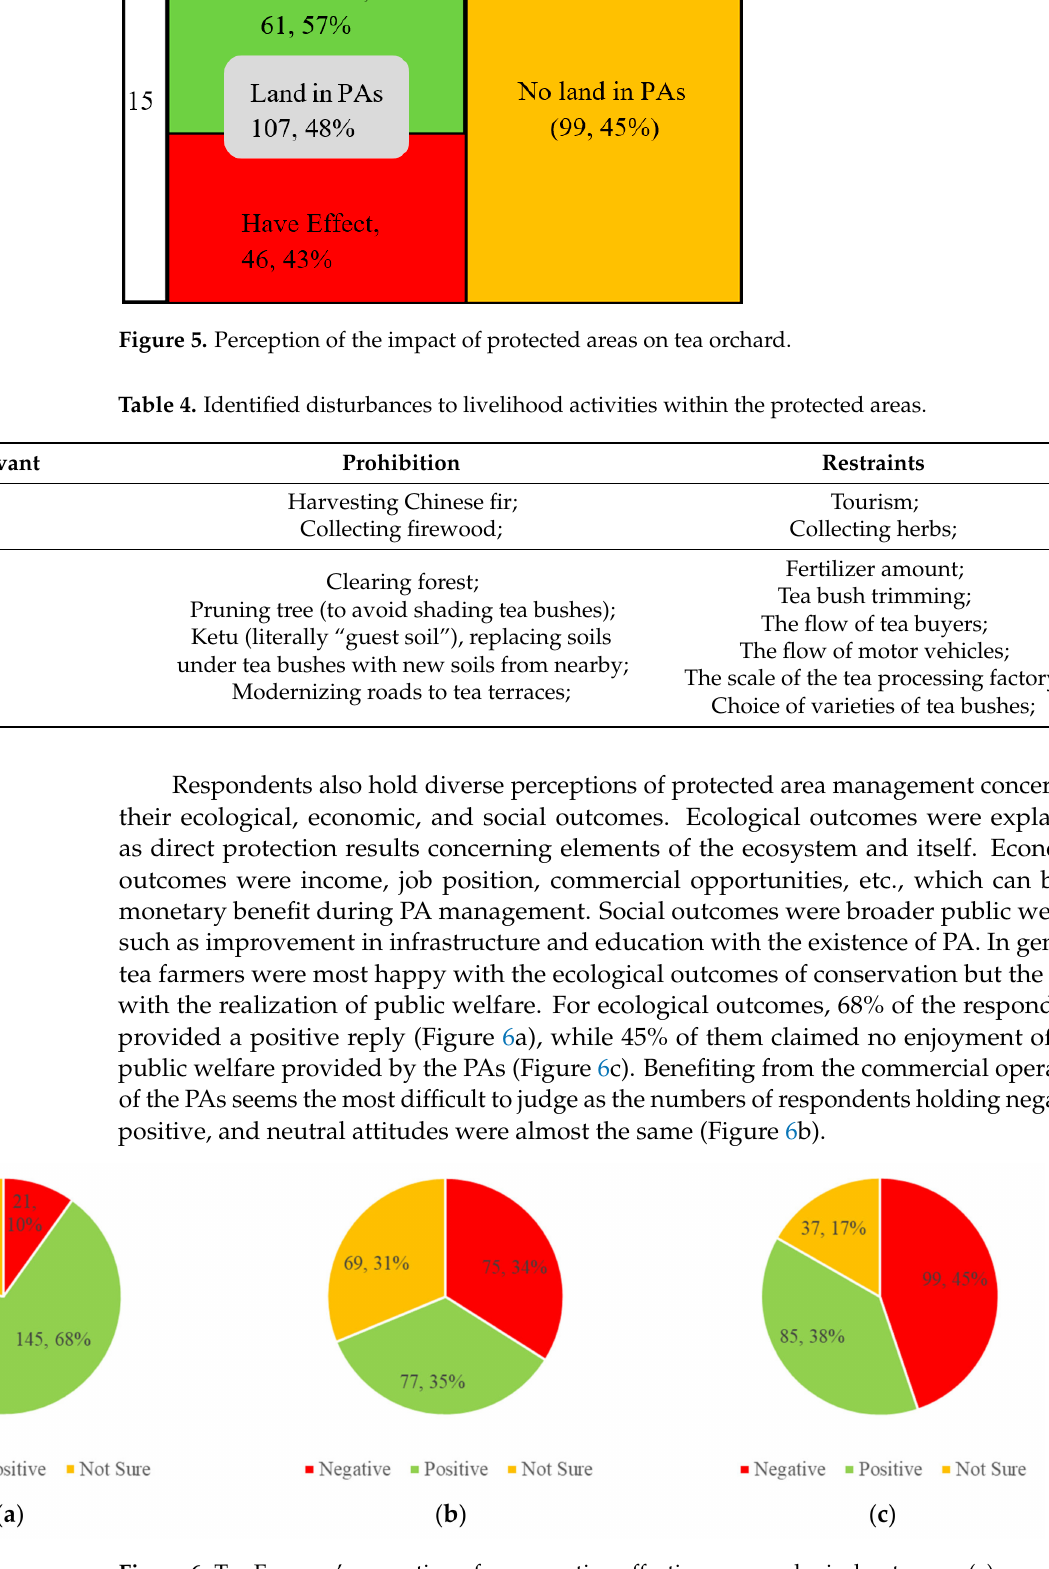
Figure 6. Tea Farmers’ perception of conservation effectiveness: ecological outcomes ( a ), economic benefit ( b ), and public welfare ( c